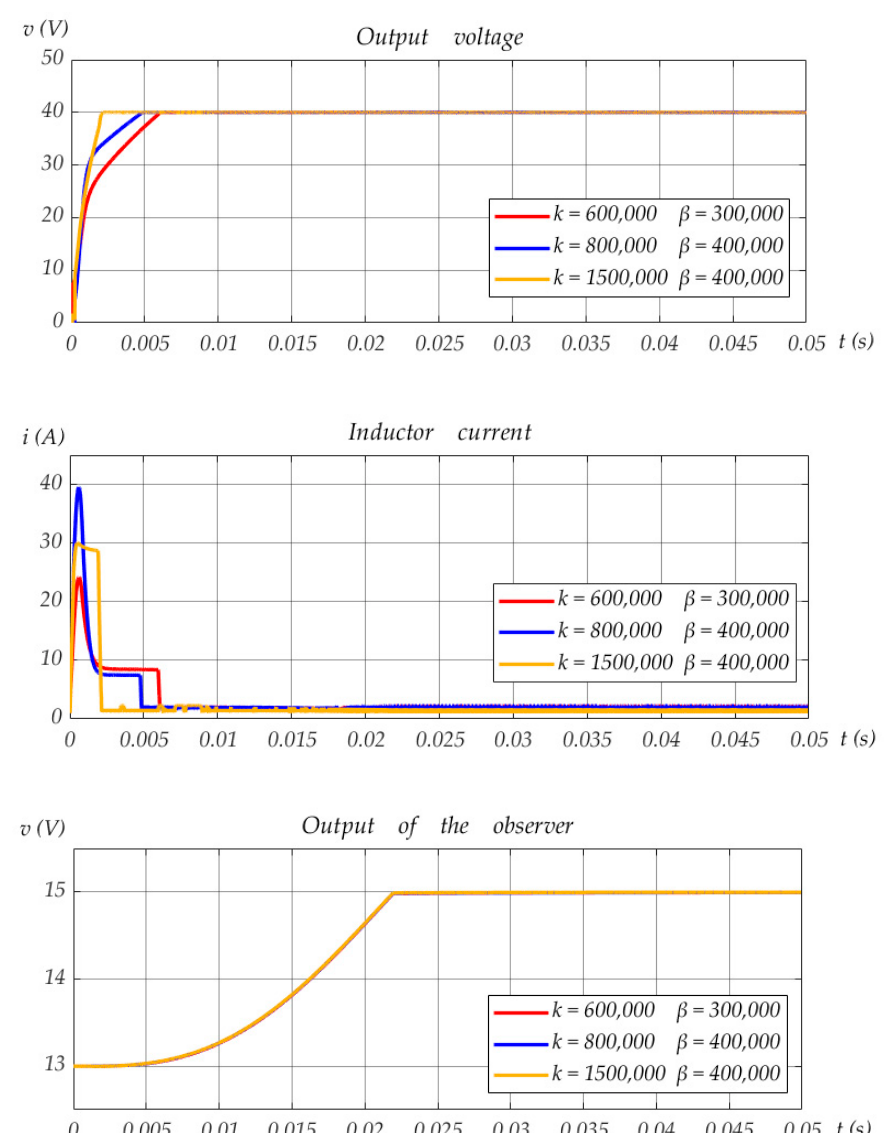
Figure 4. Transient of boost converter feeding CPL under the proposed controller.